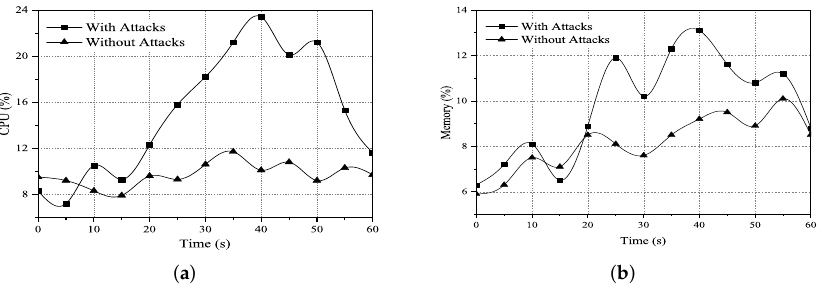
Figure 11. Defence overhead of PIEDefender. ( a ) CPU. ( b ) Memory.